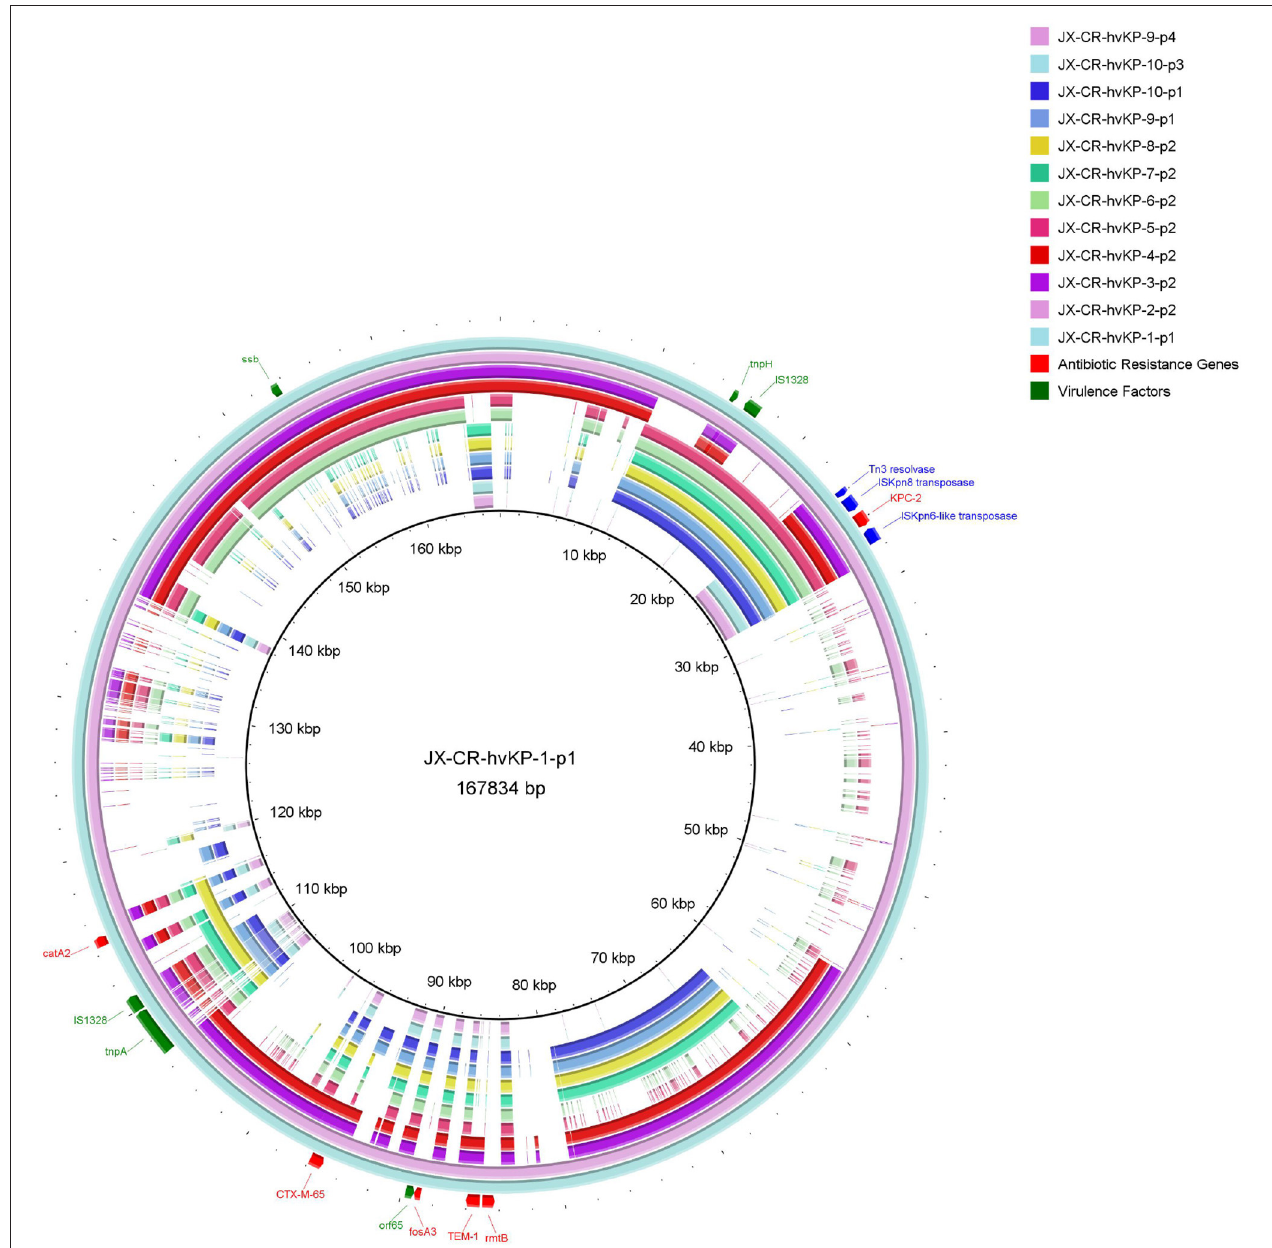
FIGURE 2 | Gene map of twelve NTE KPC plasmids harbored by CR-hvKP strains. JX-CR-hvKP-5-p2 and JX-CR-hvKP-6-p2 are from ST23 CR-hvKP, and the others are from ST11 CR-hvKP. The circular map was generated using the BLAST Ring Image Gnerator. A sequence comparison showed the polymorphism of bla KPC plasmids in